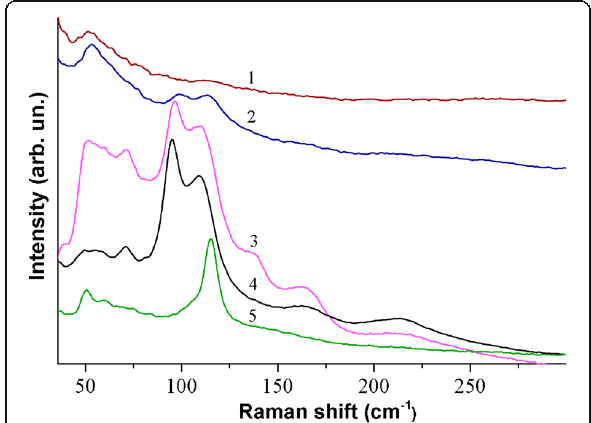
Fig. 6 Raman spectra of CH 3 NH 3 PbI 3 films formed of the 1:1 mixture of PbI 2 and CH 3 NH 3 I in DMF: directly after deposition on a glass substrate at T = 90 °C (1); after irradiation by laser light for 200 s (2); after irradiation for 400 s (3). Raman spectra of films formed from the solution of pure PbI 2 (4) and CH 3 NH 3 I (5) in DMF. All spectra were obtained with λ exc = 532 nm at room temperature